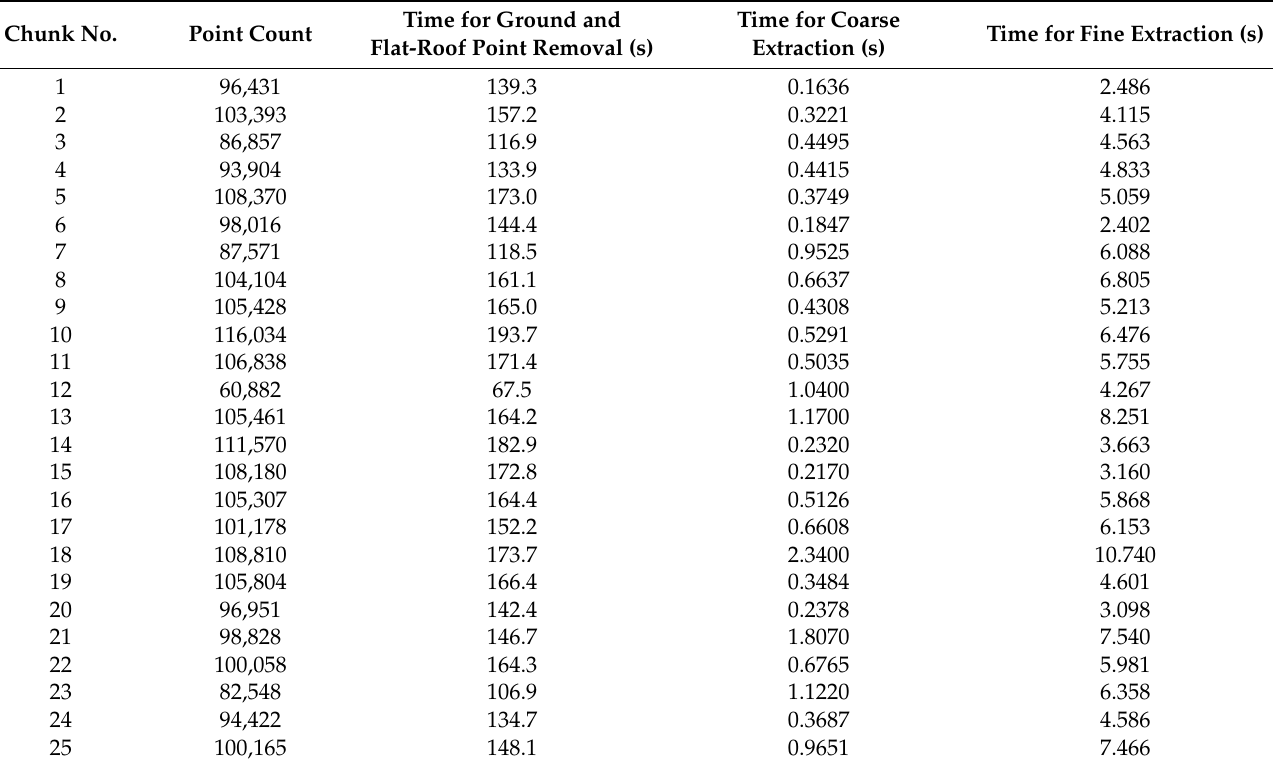
Figure 15. Airborne LiDAR data chunking. Table 5. Time consumption for airborne LiDAR data processing.